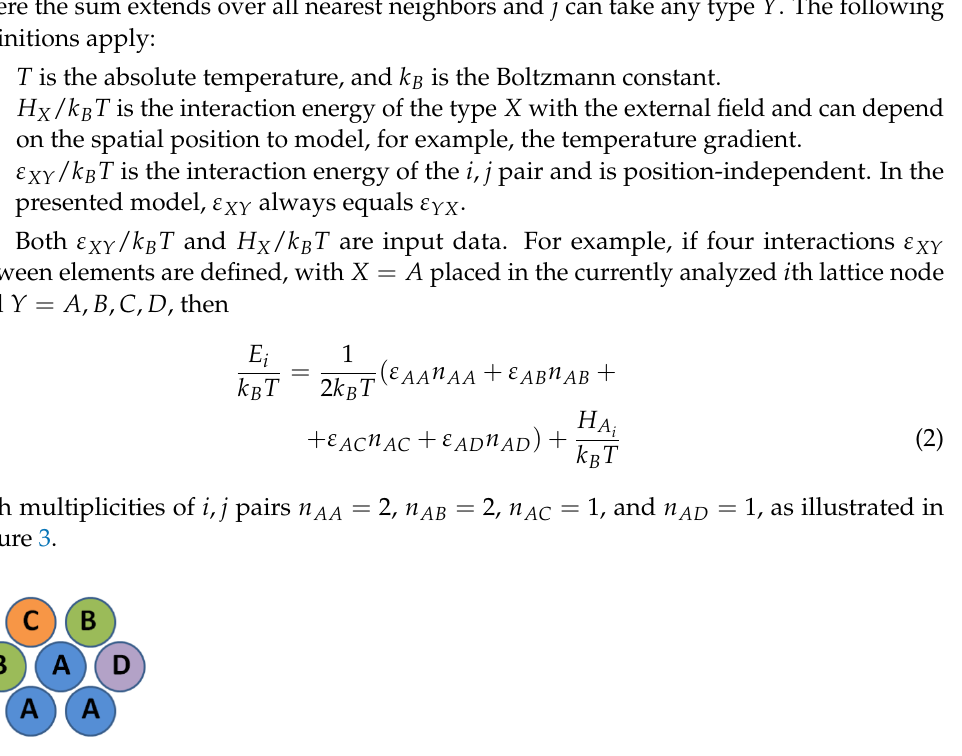
Figure 3. Example local configuration of interacting types shown in